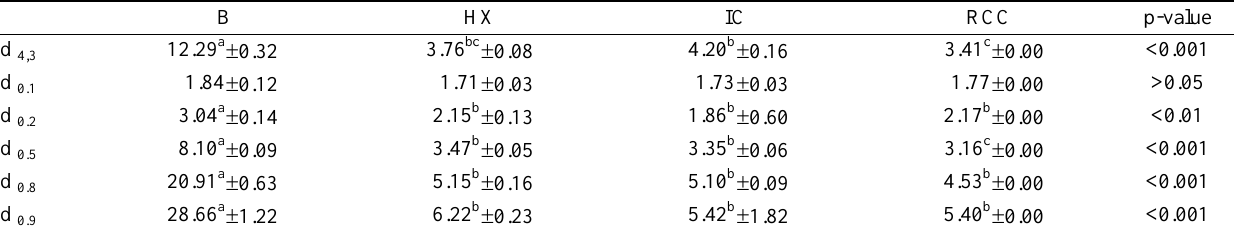
Table 5. Milk fat globule size (MFGS;  m) distribution in buffalo (B), Holstein cross (HX), Indigenous cattle (IC) and Red Chittagong Cattle (RCC) milk